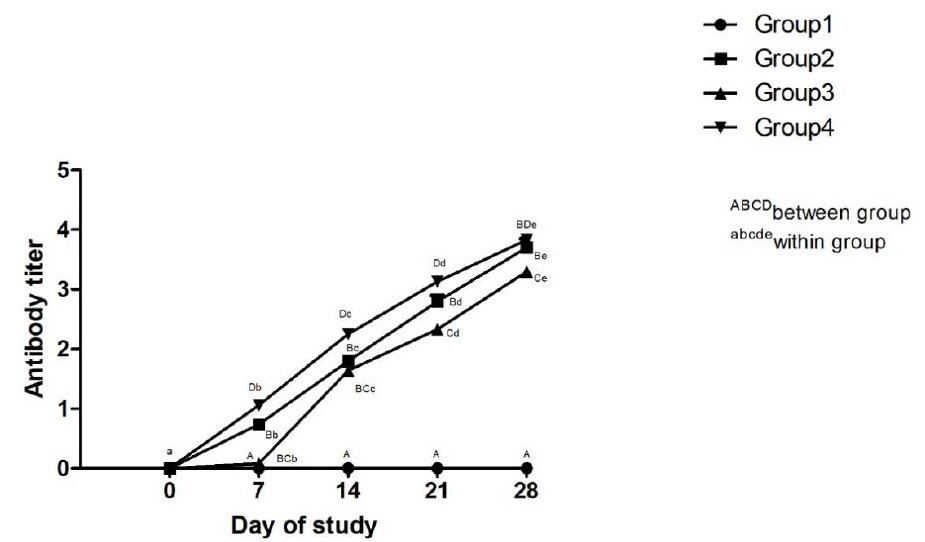
Figure 6. Effect of adjuvanted, sonicated antigens on antibody titer in rabbits.